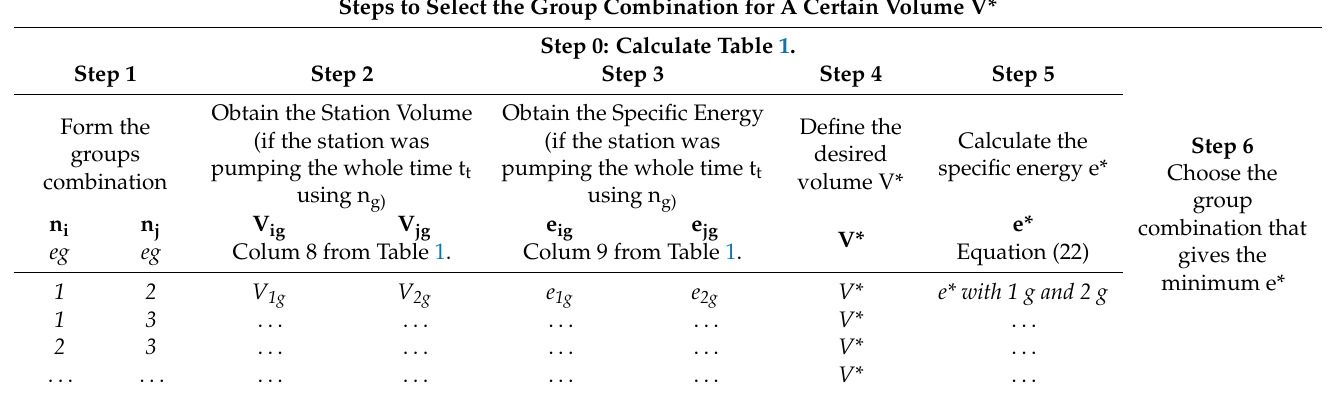
Colum 9 from Table 1.